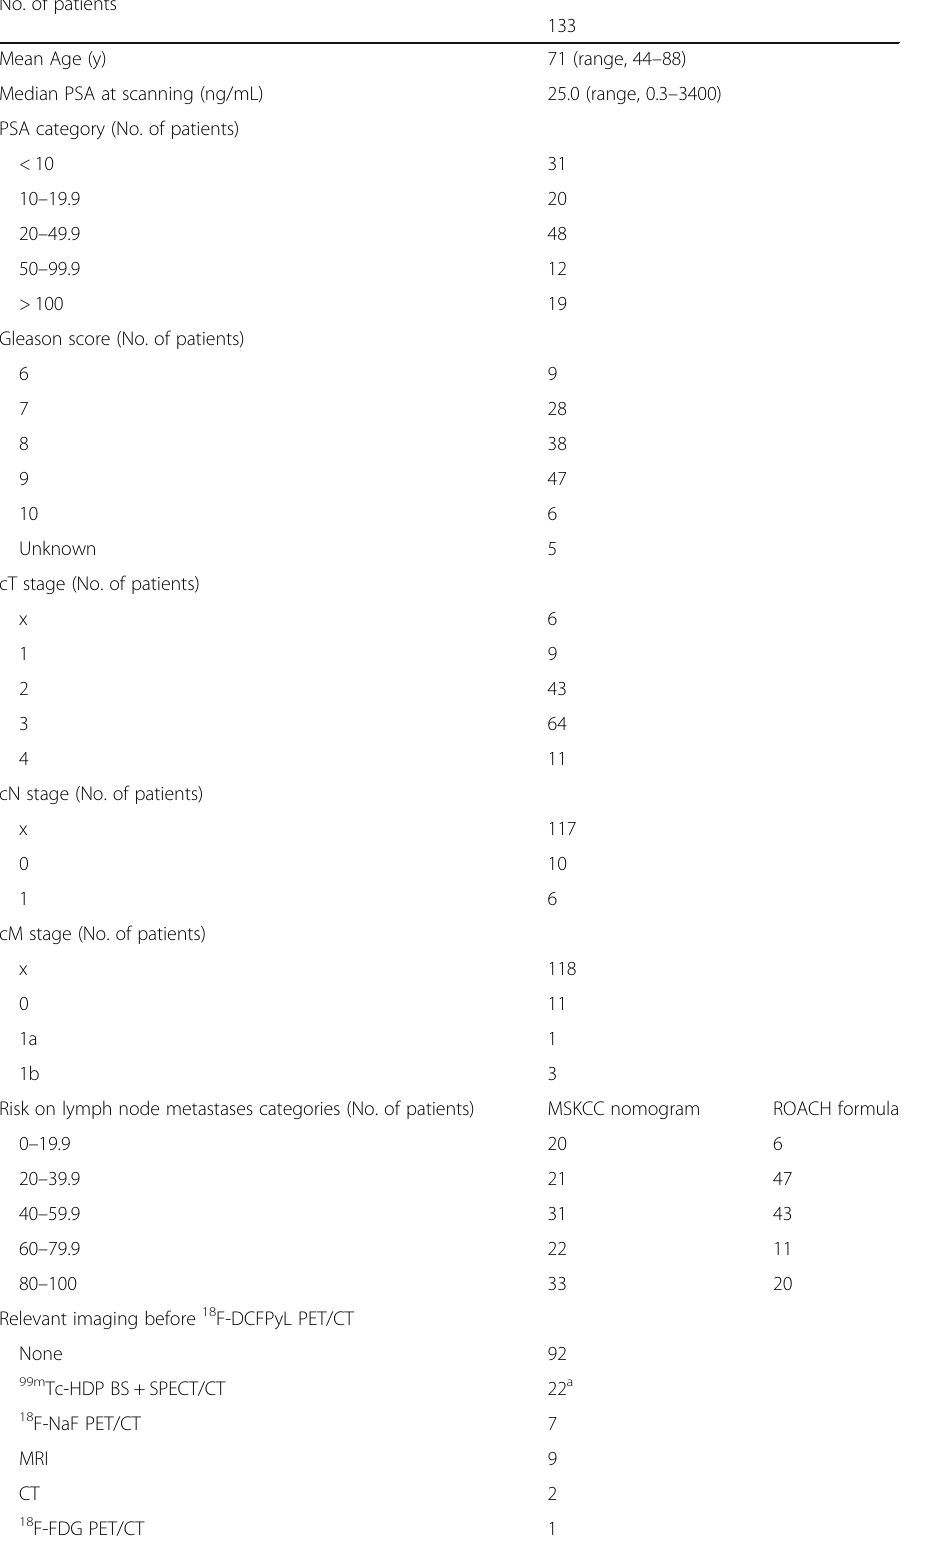
Table 1 Patients ’